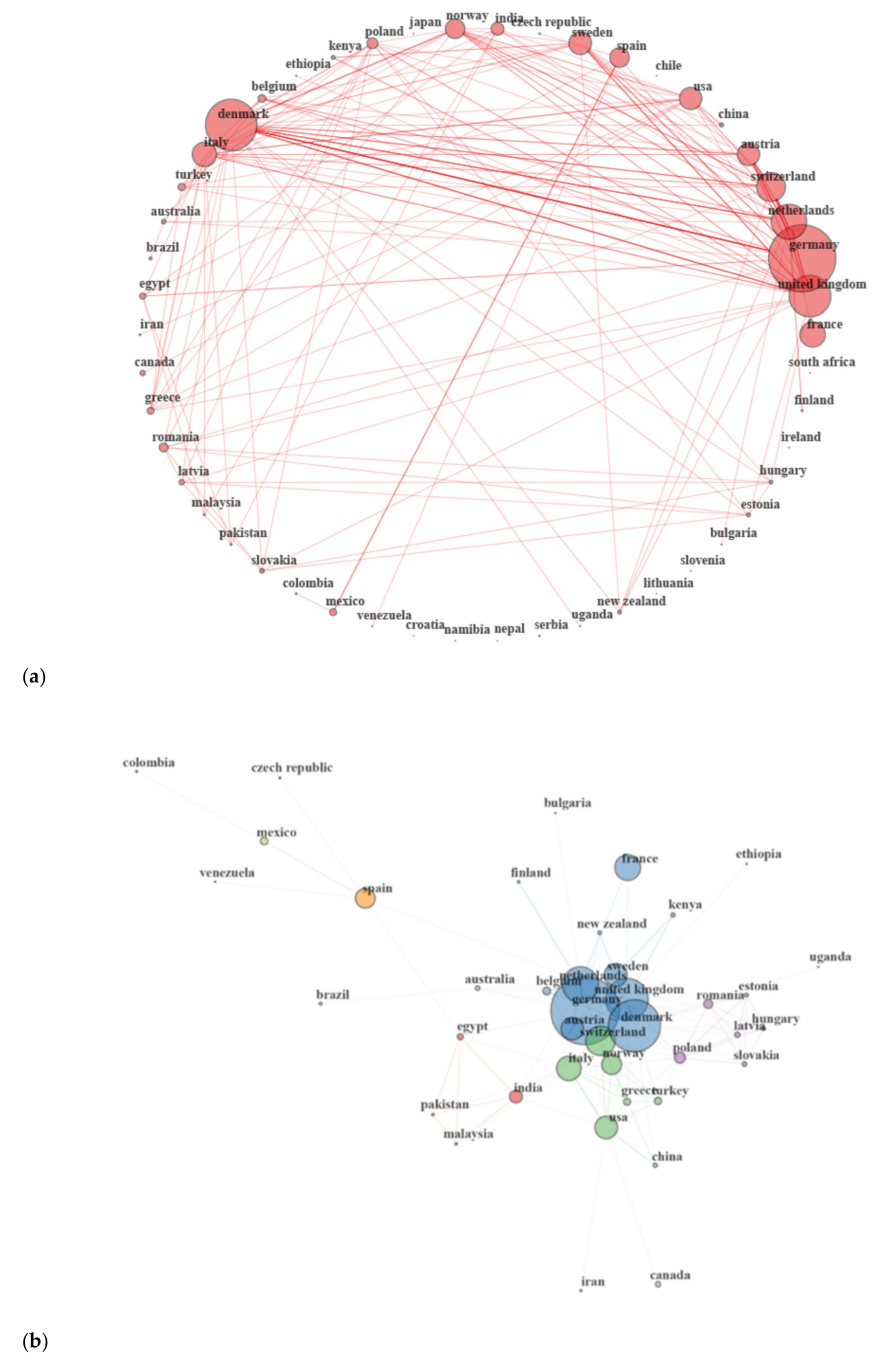
Figure 5. Country collaboration among countries of the database ( a ) without clusters using circle visualization and ( b ) with clusters and removing isolate vertex using Fruchterman–Reingold visualization. Each node size is proportional to the number of direct connections. The bigger the node, the more connections it has. Lines (link) between nodes represent direct connections and thickness is proportional to the number of studies involved in each direct connection. In ( b ), node colors identify clusters using the Walktrap algorithm and dash lines connect nodes of different clusters. The closer two countries are located on the map, the stronger the relation between